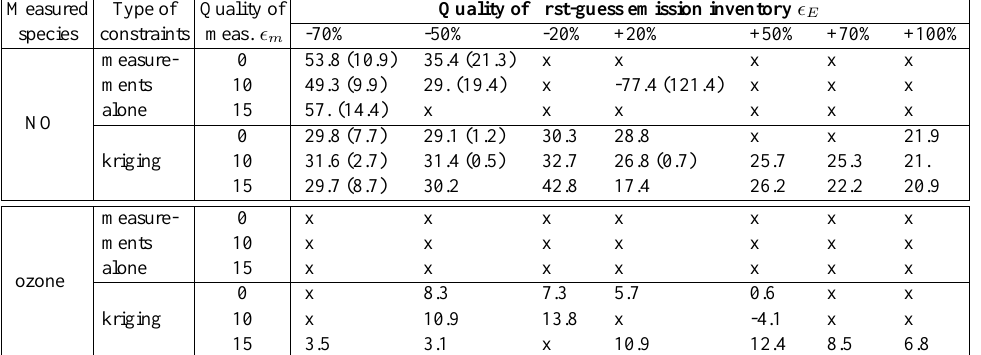
Table 1. Average scores of optimizations (in %) (and matching variances) for NO x inversion with two types of NO or ozone constraints. x = convergence not reached. of Table 2, adding the B matrix leads to a slight homoge- nization of the space and time distribution of the corrections compared to the m-case. Finally, when using kriging, the corrections are homogeneously distributed and the first-guess difference of 50% with the true fluxes is reduced to an aver- age 34.3%.